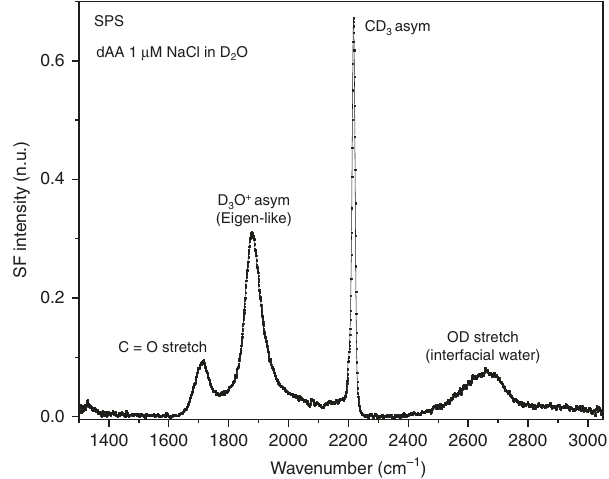
Fig. 2 Isotopic substitution proves the OH stretching assignment. VSF spectrum collected under the SPS polarization combination of a dAA monolayer on a 1 μ M NaCl solution in D 2 O (pD ~6.4) at a constant surface pressure of 20 mN m − 1 (area per molecule ~20 Å 2 ). Temperature. 22 °C. The assignments are taken from 26,28 and this study (see text).